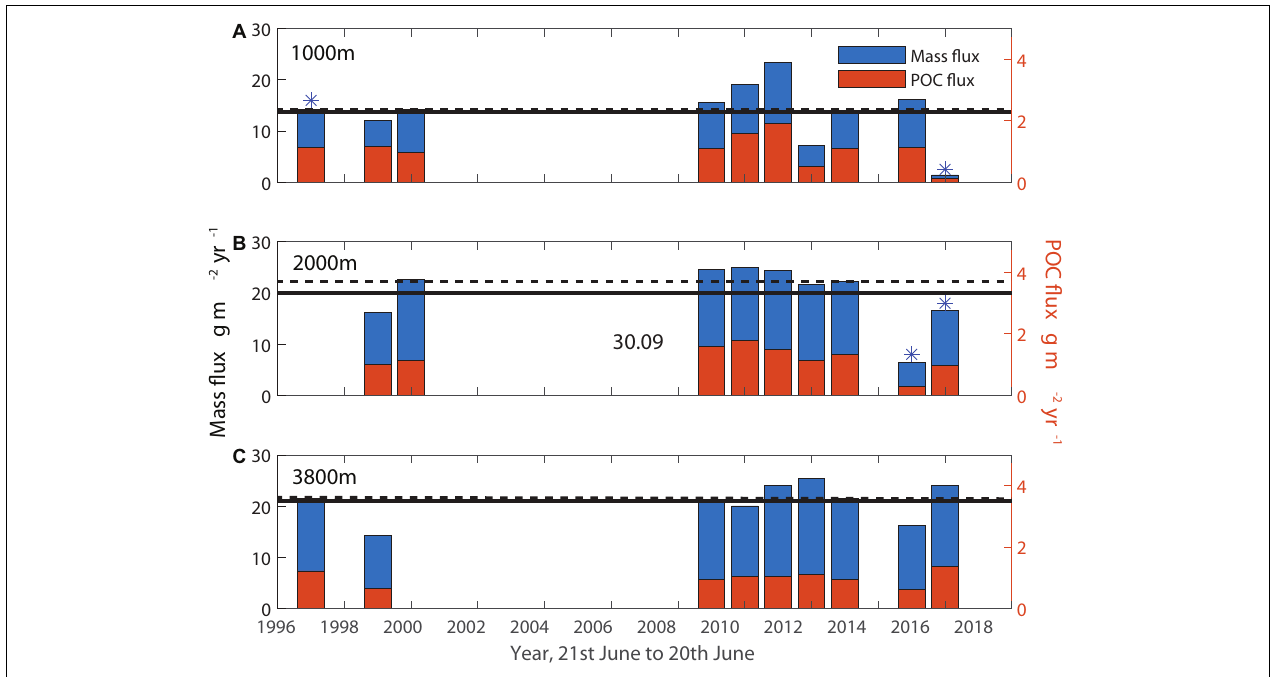
FIGURE 4 | Annual mass and POC fluxes in g m - 2 yr - 1 . POC fluxes for years marked with * had gaps filled with average %POC values to complete an annual cycle for this figure. Median (dashed line) and average (solid line) mass fluxes do not include the years marked with *. (A) 1000 m, (B) 2000 m, (C) 3800 m.